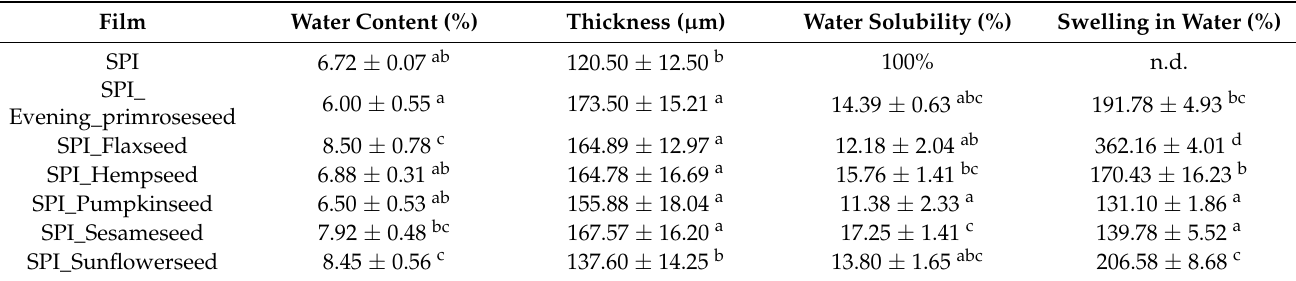
Table 1. Water content, thickness and water solubility of soy protein isolate–oilseed flour